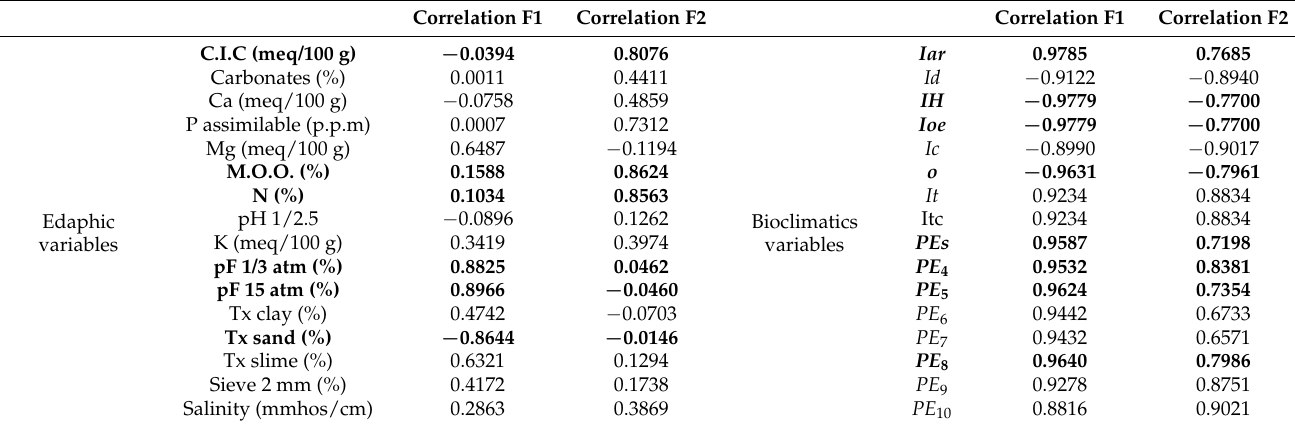
Table 4. Correlation with the first two axes (F1 and F2 explained the higher variability found in the first two axes of the factor analysis; F1 = 23.75% and F2 = 21.80% in the soil variables, and F1 = 54.91% and F2 = 37.07% in the bioclimatic variables). Absolute correlation values over 0.8 have been considered for the soil variables, and absolute correlation values higher than 0.95 for the bioclimatic variables. The variables selected are shown in